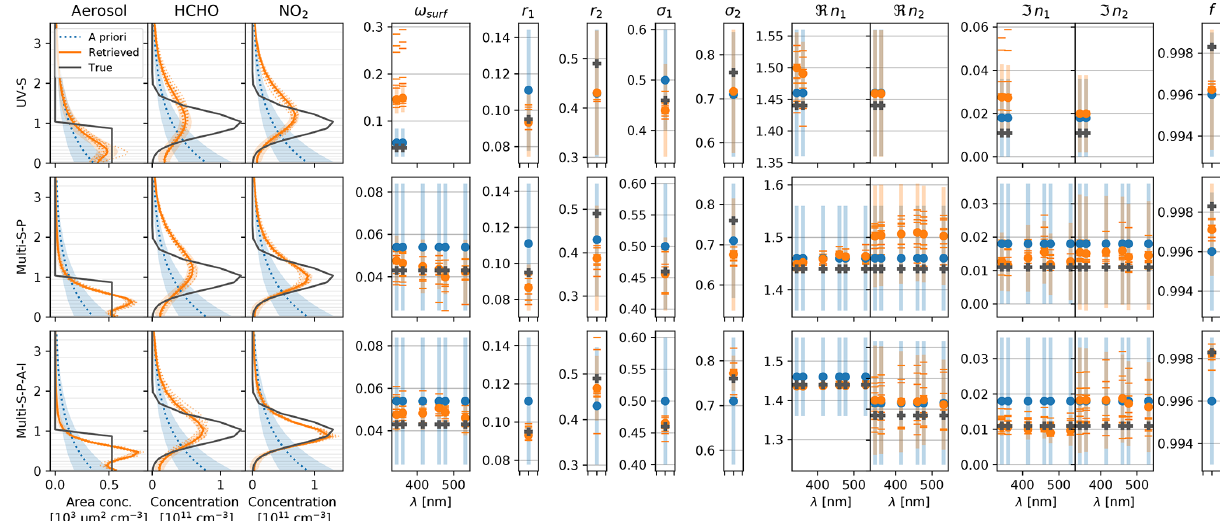
Figure 9. Retrieval results for the Aer6-TG7 scenario. Different subplot rows show different measurement modes (see captions on the left). The first three subplot columns show profiles with altitude in kilometres on the y axis. The remaining columns show values ( y axis) of other state vector elements (see captions at the top), occasionally for different wavelengths ( x axis). Blue lines and symbols show a priori values, and dark grey lines and crosses show true values. Thick orange lines and circles indicate results for a noiseless retrieval, while thin dotted lines and dashes indicate the results of the 10 retrievals with random noise added to the observations. Transparent areas and bars indicate uncertainties.